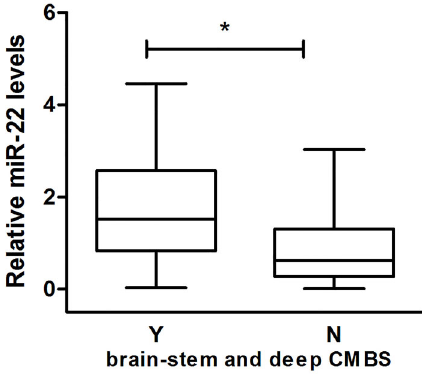
Figure 5. Boxplots comparison of the relative expression of miR- 22 in patients with (Y) and without (N) cerebral microbleeds (CMBs) in brainstem and deep area. Data are reported as median and interquartile range. *P o 0.05 (Mann-Whitney